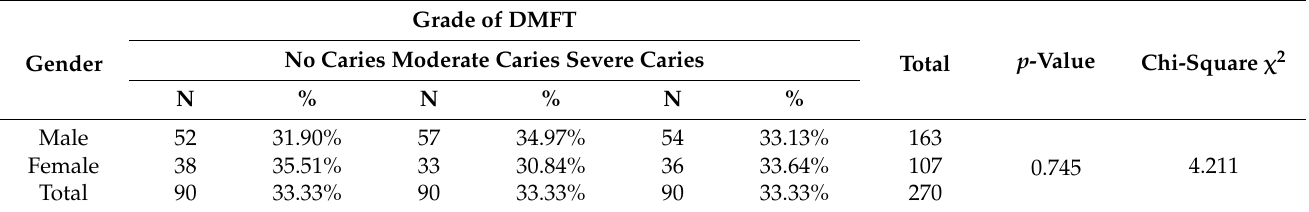
Table 1. Gender distribution as per DMFT categorization among the total population.